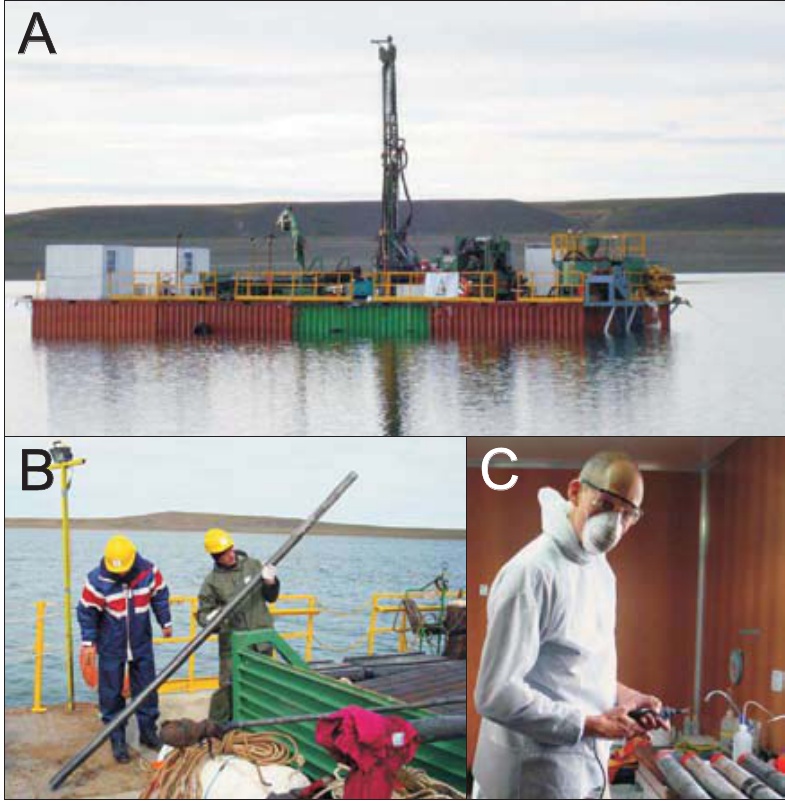
Figure 2. [A] Drilling platform GLAD 800. After retrieval [B], the cores were transported from the platform to the laboratory where they were sampled at once